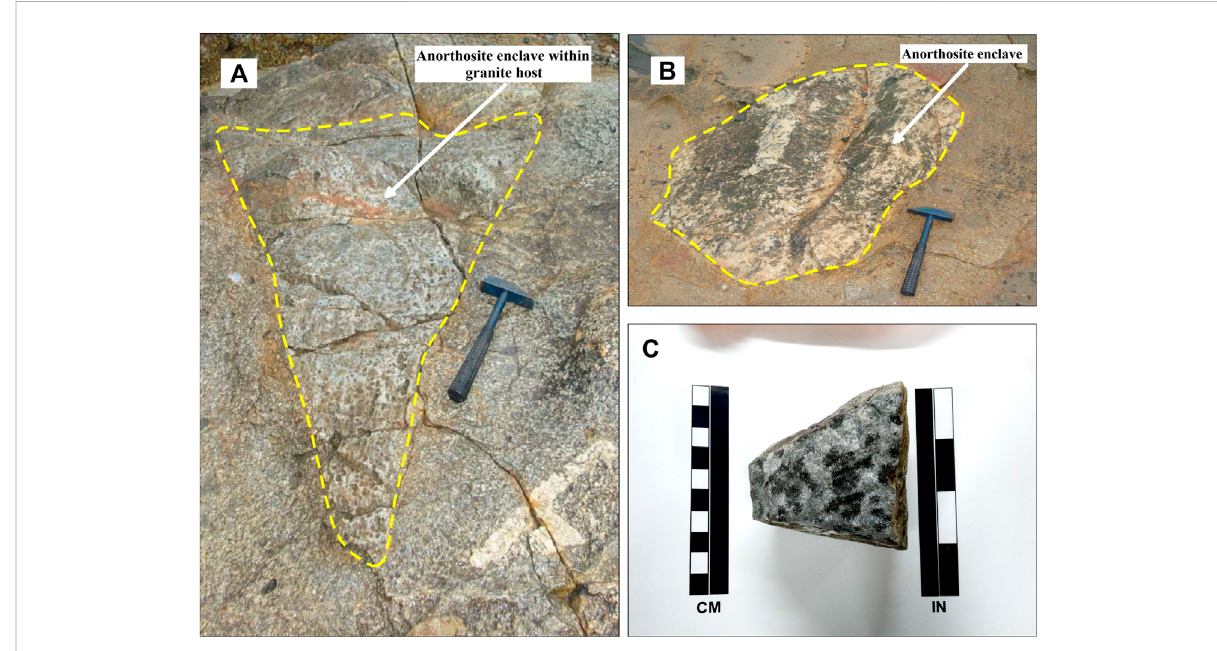
FIGURE 2 (A,B) anorthositeenclaveswithinProterozoicgranitefromtheRajgirlocality(N24 ° 59 ′ 33.5 ″ ,E85 ° 15 ′ 47.6 ″ )ofnorthernCGGC. (C) aphotograph of the hand specimen of anorthosite enclave.